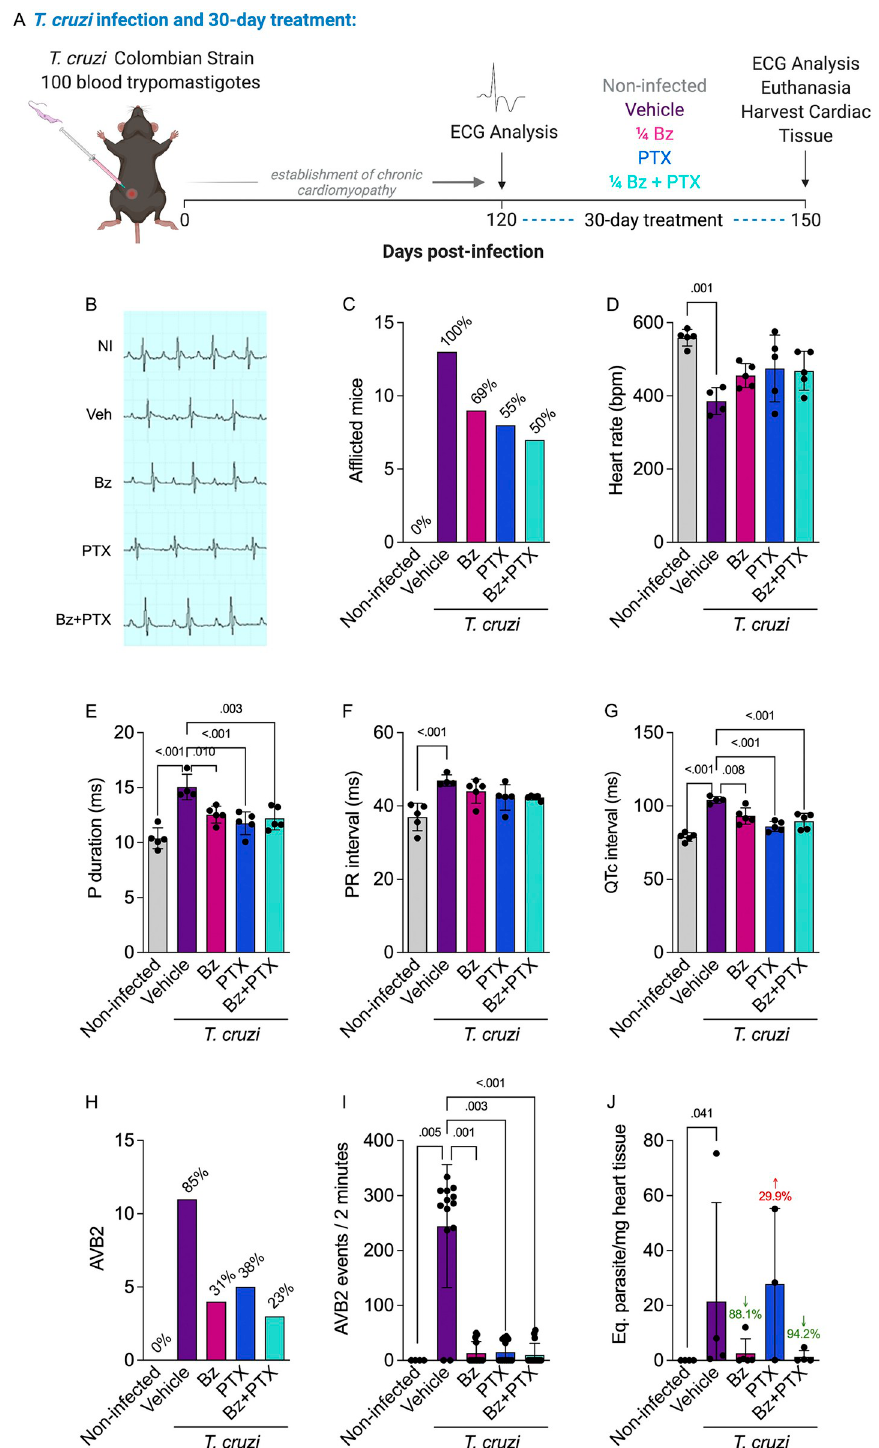
Fig 1. Chronic Chagas cardiomyopathy model and treatment with a suboptimal dose of Bz, PTX, or Bz+PTX. (A) Experimental design of infection and treatment. Mice were infected and treated daily from 120 to 150 dpi with vehicle alone, suboptimal dose of Bz ( ¼ dose, 25 mg/kg), PTX (20 mg/kg), or a combined therapy of Bz+PTX, and analyzed at 150 dpi. Created with Biorender. (B) Representative ECG register segments of sex- and age-matched noninfected controls and infected mice (150 dpi) injected with vehicle, Bz, PTX or Bz+PTX. (C) Frequency of afflicted mice by any